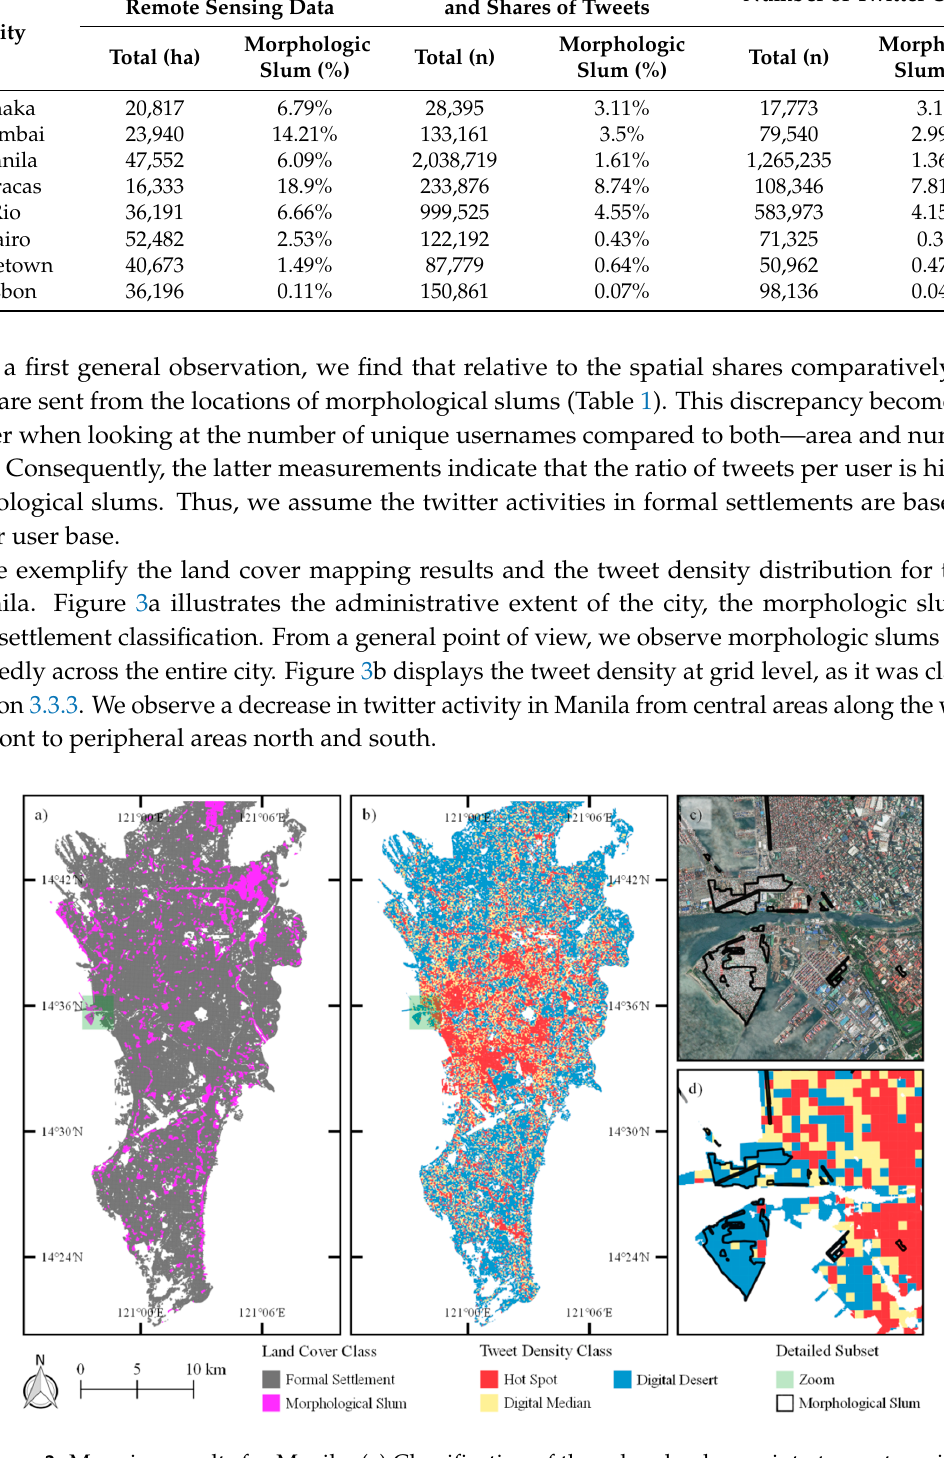
Figure 3. Mapping results for Manila: ( a ) Classification of the urban landscape into two categorical classes ‘formal settlement’ and ‘morphological slum’; ( b ) Tweet density class projected onto the grid; Detailed subset showing ( c ) settlement structures at the western waterfront and ( d ) corresponding tweet density class.